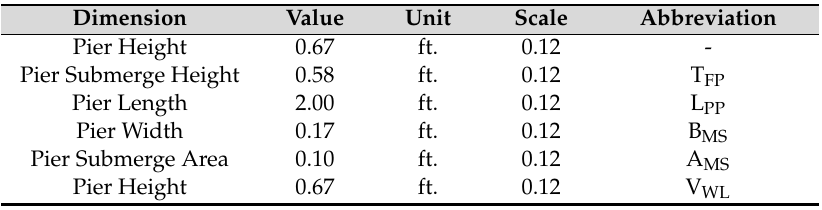
= 0.667 (cid:48) and 1.833 (cid:48) . bb